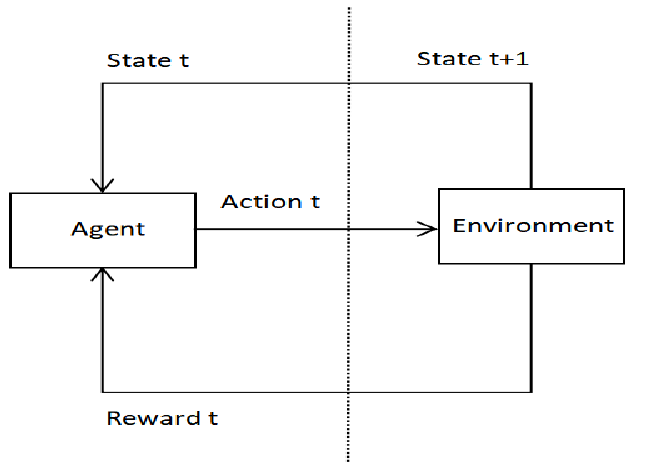
Figure 2. This is a reinforcement learning system, where the final output is given by the agent.